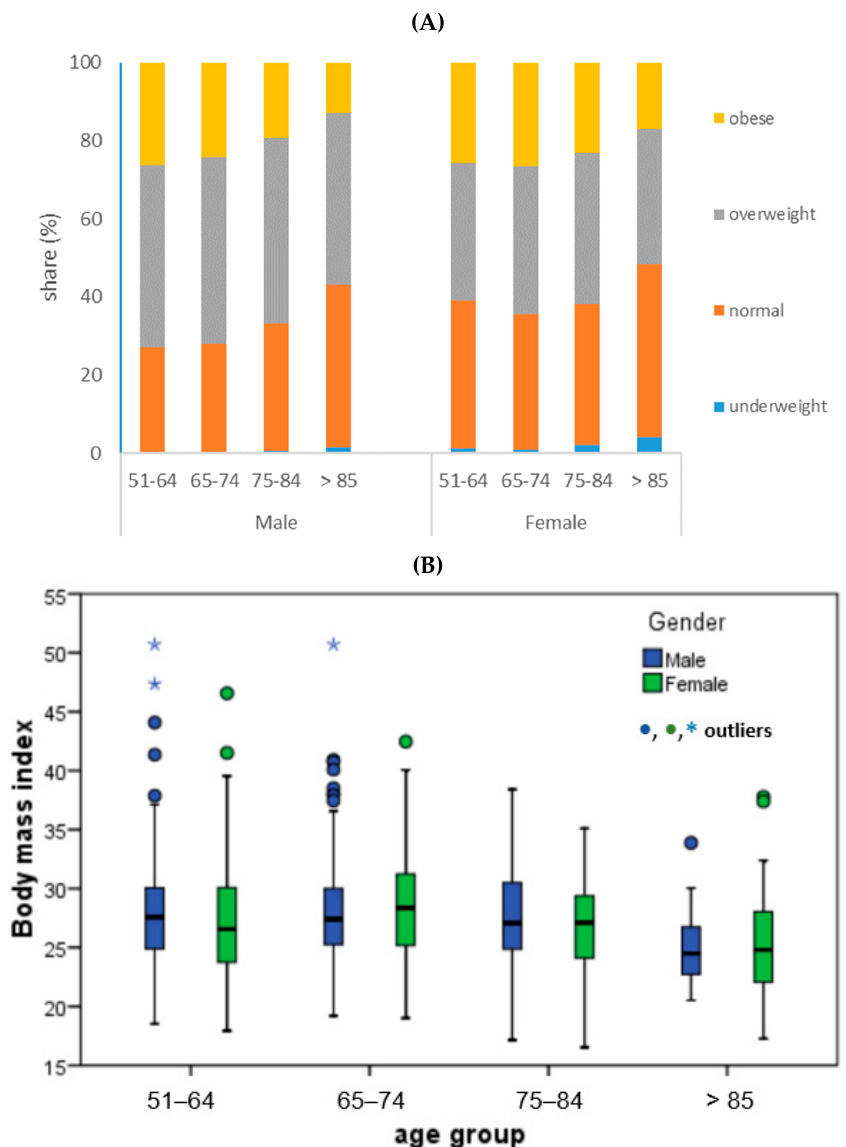
Figure 2. Distribution of the BMI categories based on age and gender, as indication of nourishment of the total participant set ( A ) as well as for Croatia ( B ).